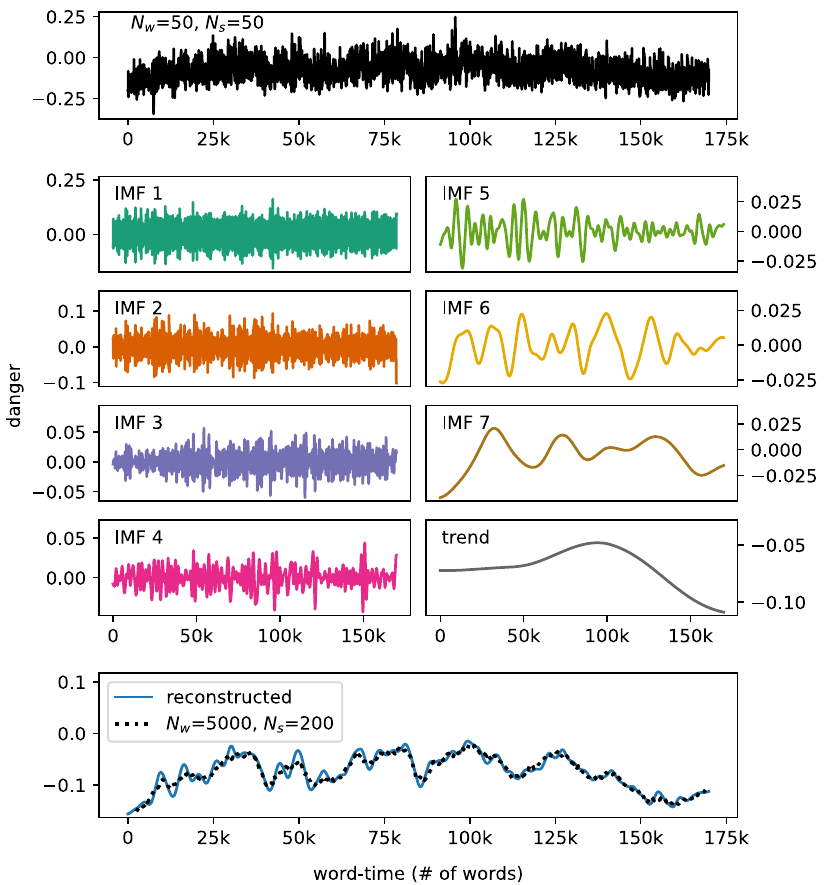
Fig. 3 The decomposition of the danger time series of “ The Iliad ” using EEMD. The raw time series was obtained using non-overlapping windows with N = 50, N = 50 (top panel), and the IMFs and the trend obtained from EEMD are shown. The lowermost panel shows the sum of IMFs 5 – 7 and the trend w s ("reconstructed''), superimposed with the danger time series obtained using larger overlapping windows ( N w = 5000, N s = 200). Note that the partial reconstruction from the time series obtained using smaller windows is very similar to the raw time series obtained using larger, overlapping windows.